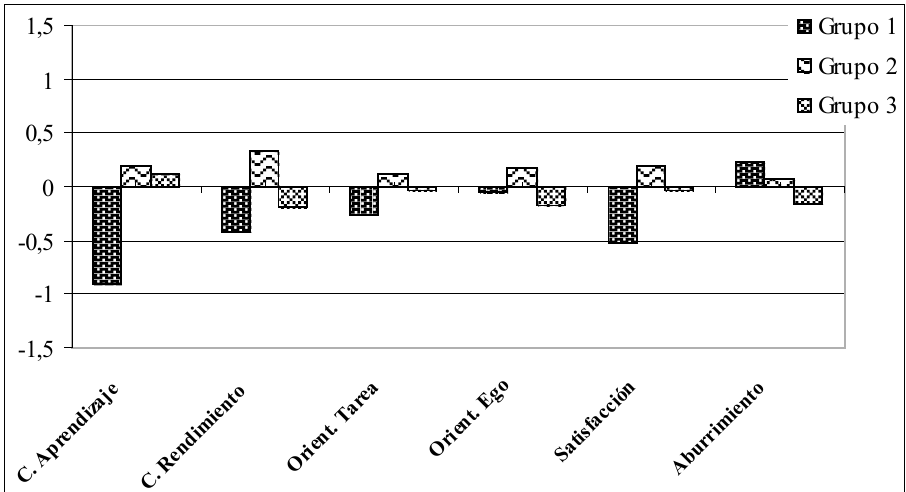
Figura 2 . Peso del clima motivacional, orientaciones de meta y satisfacción en la EF en los tres conglomerados. En el eje vertical aparecen las puntuaciones Z